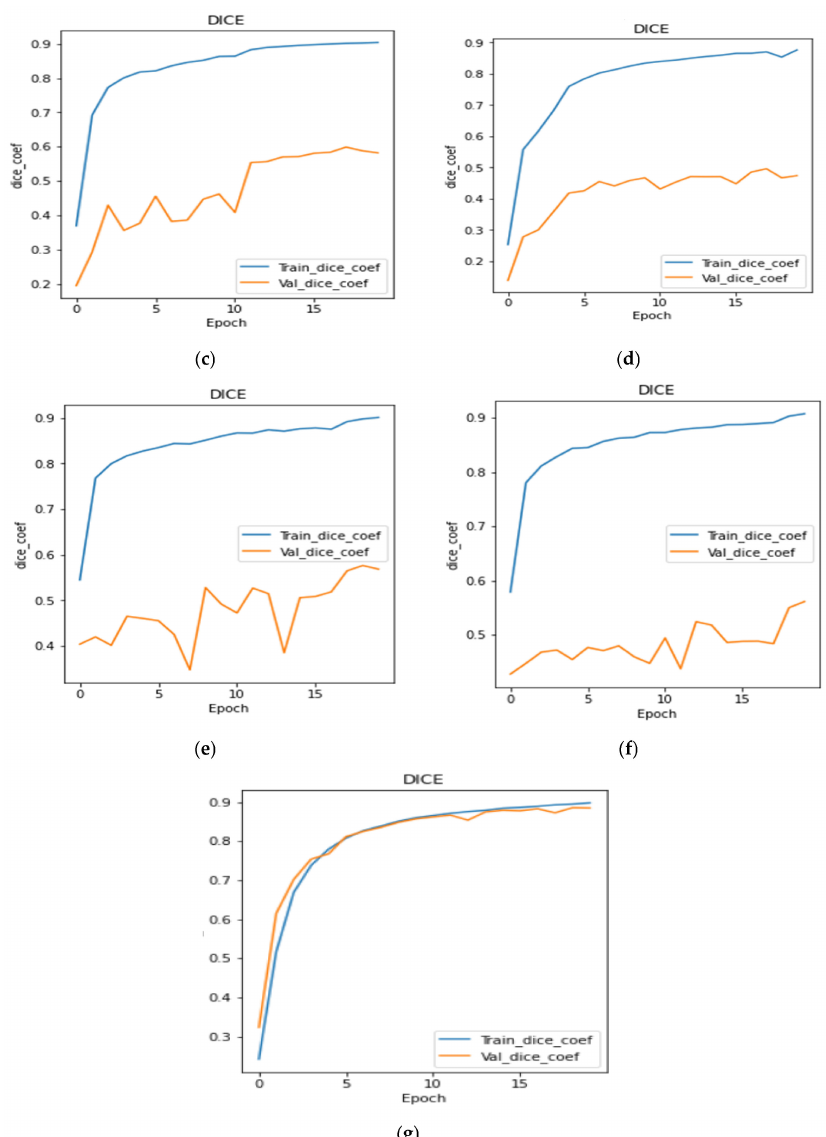
Figure 10. Dice Coefficient Plots: ( a ) DenseNet121, ( b ) Inception V3, ( c ) SeResNet50, ( d ) VGG19, ( e ) InceptionResNetV2, ( f ) EfficientNet B2, & ( g ) Proposed